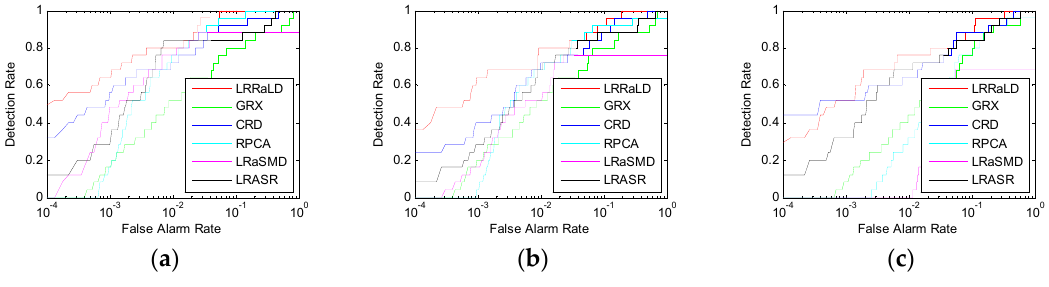
Figure 12. ROC curves under complex background using different methods: ( a ) F1; ( b ) F2; and ( c ) V1. Table 2. Average detection rates when PFA equals 0.01 (20 repetitions).